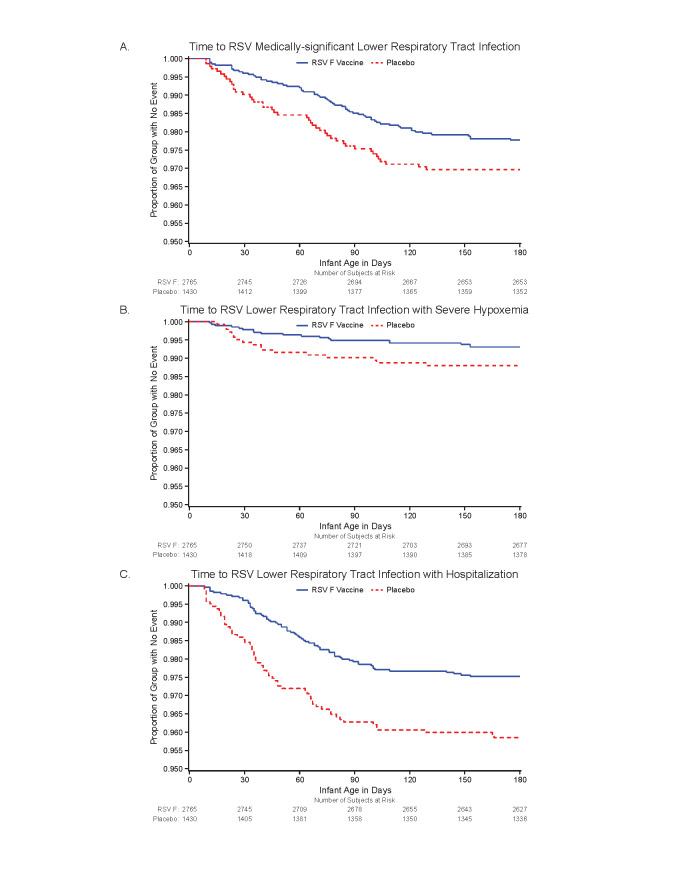
Kaplan-Meier Plots for the Primary and Secondary Efficacy Endpoints in the
Per-Protocol PopulationPanel 2a: Time to RSV Medically-significant Lower Respiratory Tract InfectionPanel 2b: Time to RSV Lower Respiratory Tract Infection with Severe HypoxemiaPanel 2c: Time to RSV Lower Respiratory Tract Infection with Hospitalization